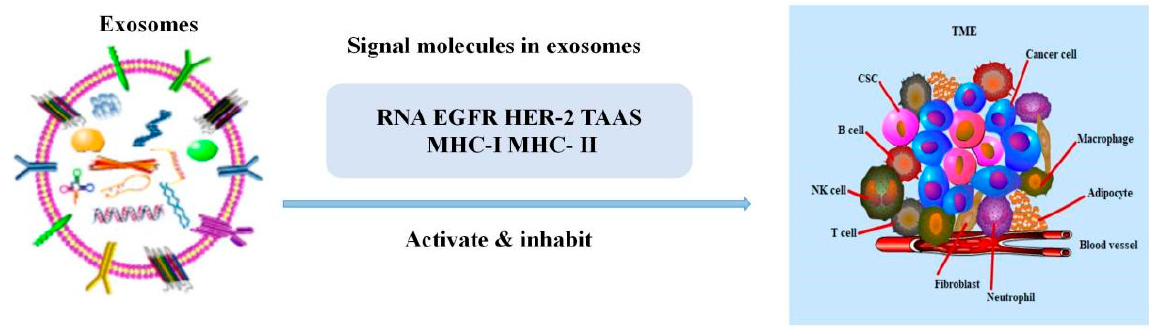
Figure 1. The relationship between exosomes and the TME. The signal molecules carried by exosomes could activate or inhibit immune cells to mediate the growth of tumor cells. Table 1. Exosome-mediated regulation of lymphoid functions in cancer.